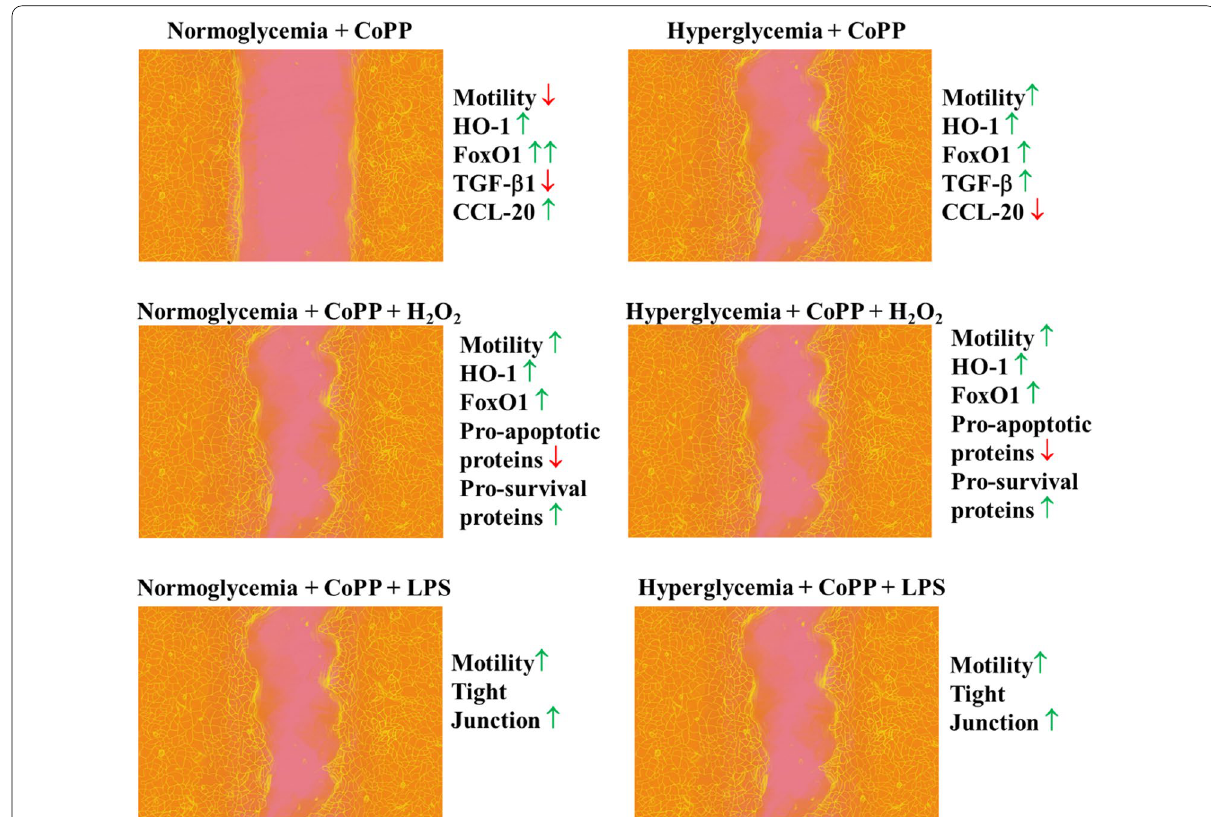
Fig. 7 Schematic diagram showing the summary of therapeutic effect of CoPP in promoting HaCaT migration. CoPP could downregulate HaCaT’s migratory capability when the cells were cultured in NG media. In contrast, compared to untreated samples, CoPP‑treatment had significantly enhanced the HaCaT’s migratory capability when being cultured in HG media. Likewise, in the presence of either H 2 O 2 or LPS, the motility of HaCaT were increased when being pretreated with